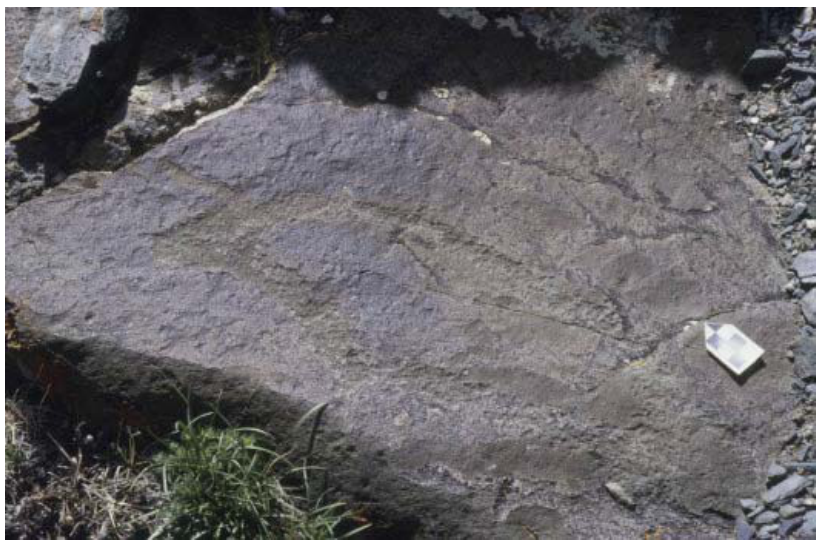
Figure 5. Aurochs. Pre-Bronze Age (Paleolithic period). Baga Oigor II. (http://oregondigital.org/u?/maic,